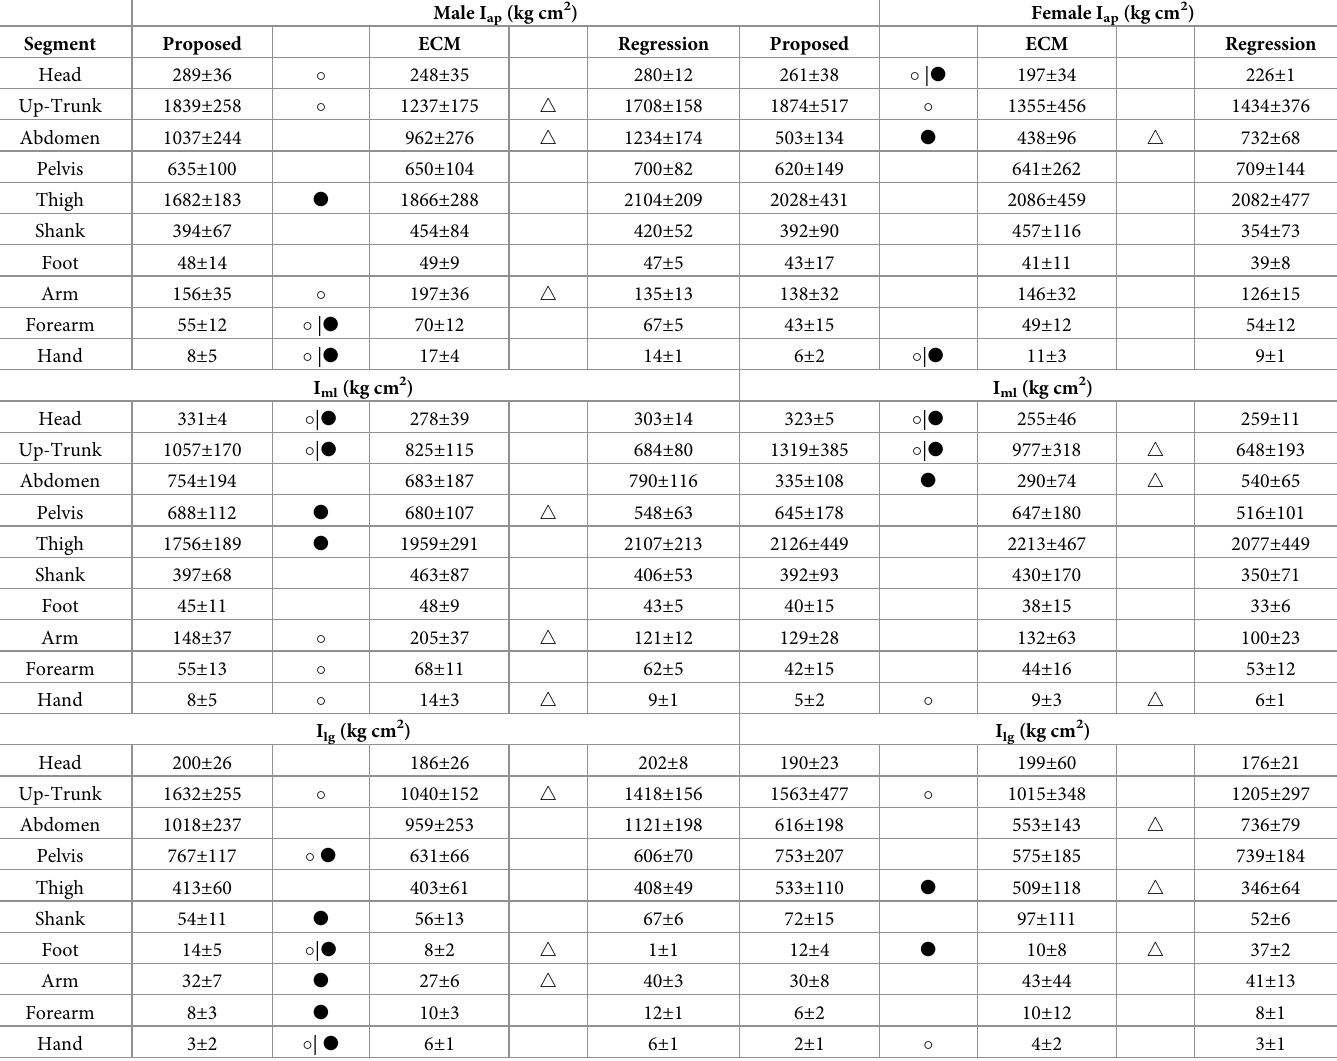
Table 4. Moment of inertia estimates (mean ± SD in kg cm 2 ) obtained using the proposed method, the ECM approach, and regression modelling for both male and female